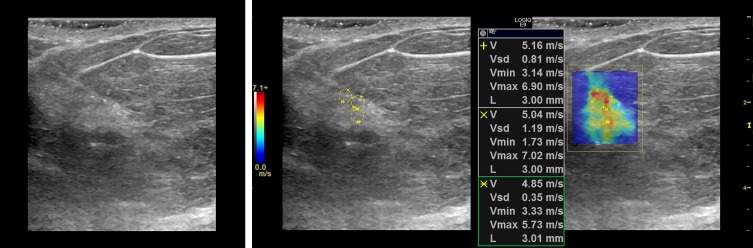
Shear wave speed map of a malignant breast mass diagnosed as invasive ductal carcinoma grade II. Emean = 76kPa.The lesion contrast on the B-mode image is considerably low due to minimal probe compression used for SWE data acquisition.